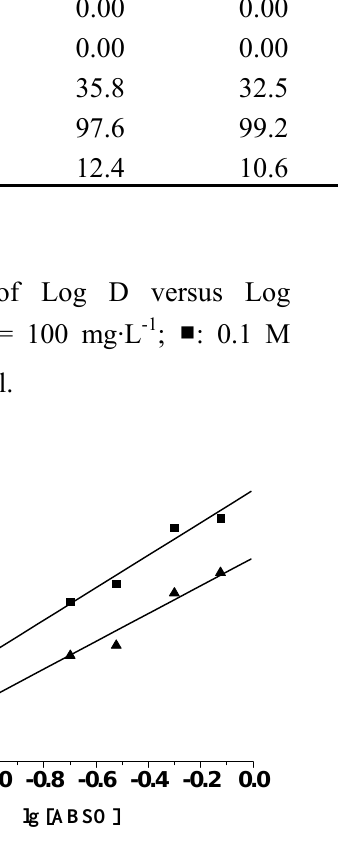
Table 1 . Effect of Stripping Agents on the Recovery of Palladium(II) Stripping Agents